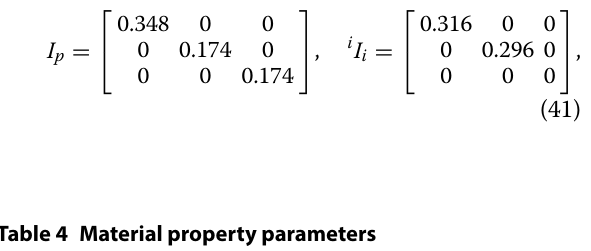
Table 4 Material property parameters Attribute Numerical value Material Steel